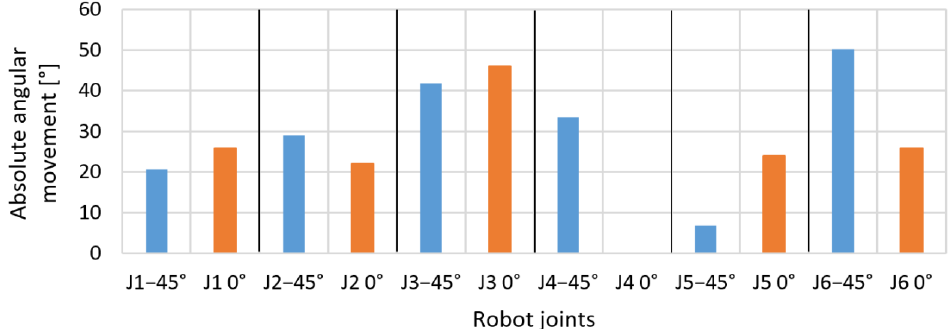
Figure 14. Absolute angular movement of robot joints during the movement along a circular path in both measuring